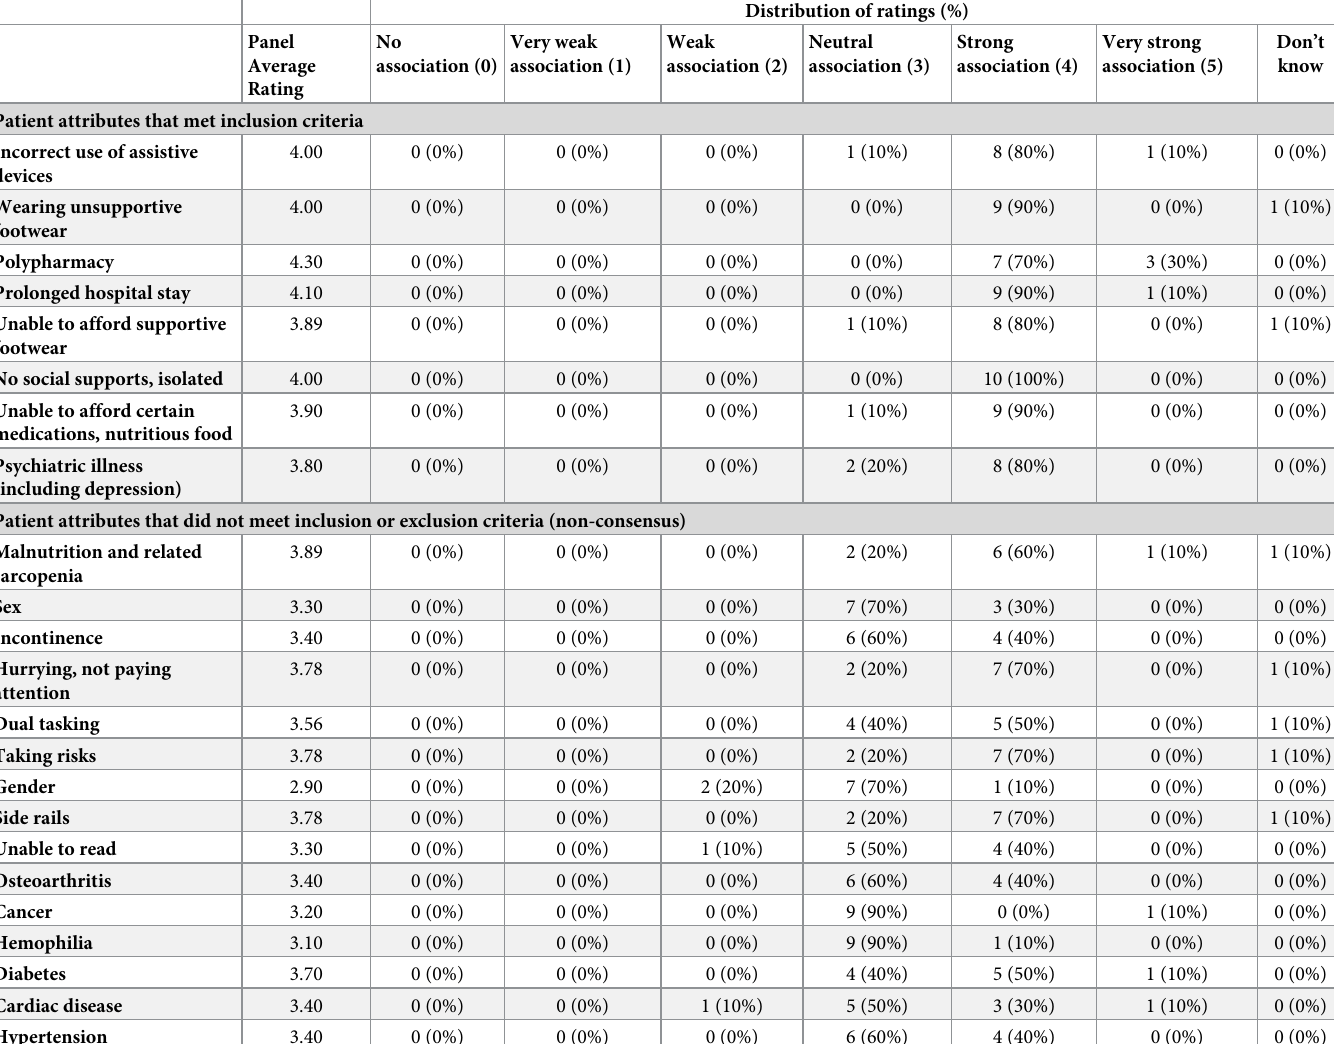
Table 5. Summary of patient attributes ratings from the second Delphi